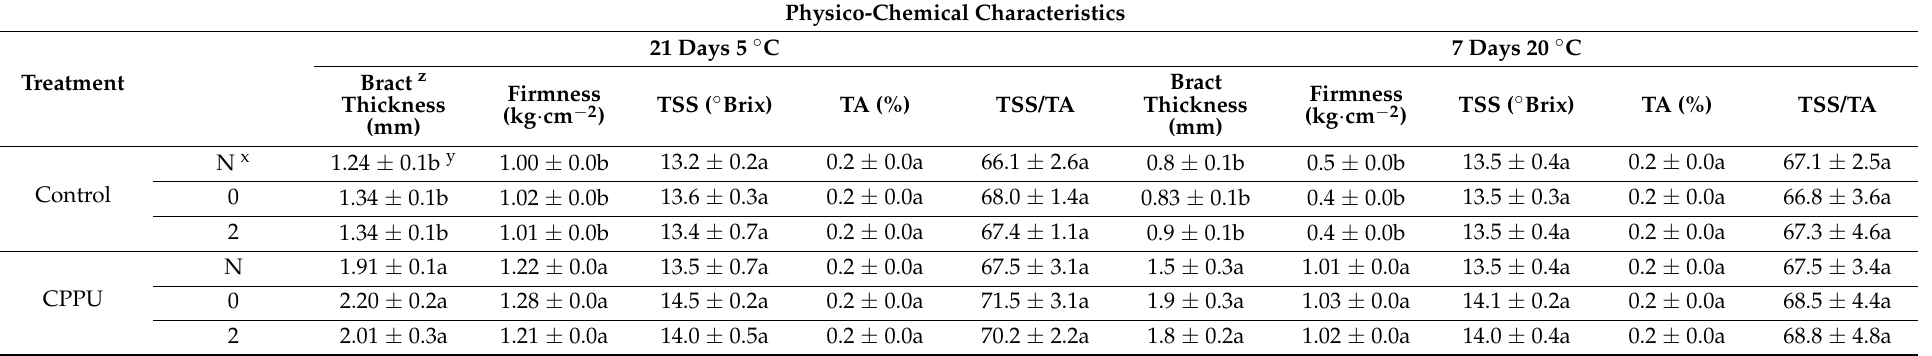
Table 2. The preharvest application of CPPU and perforation packaging on quality of red-fleshed pitaya during storage and